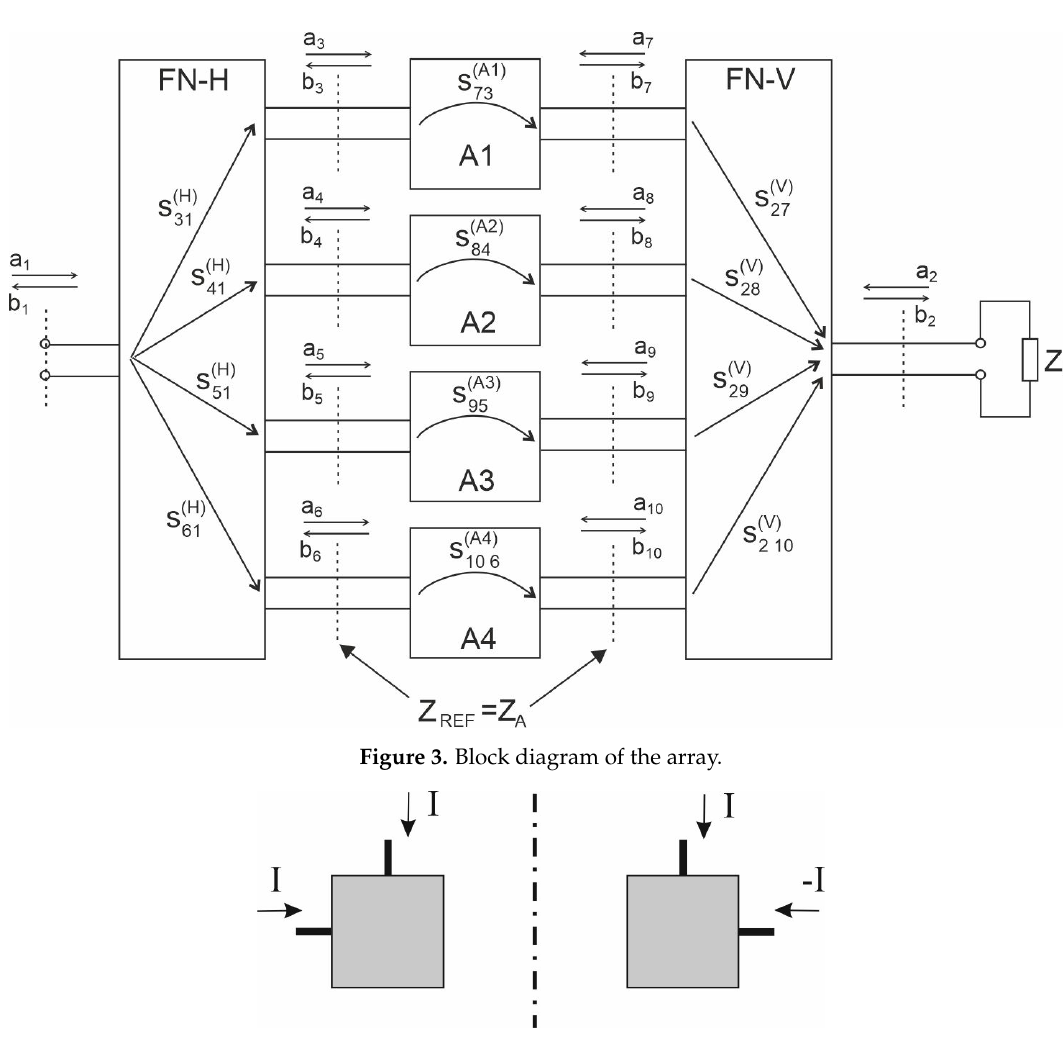
Figure 4. Concept of mirror